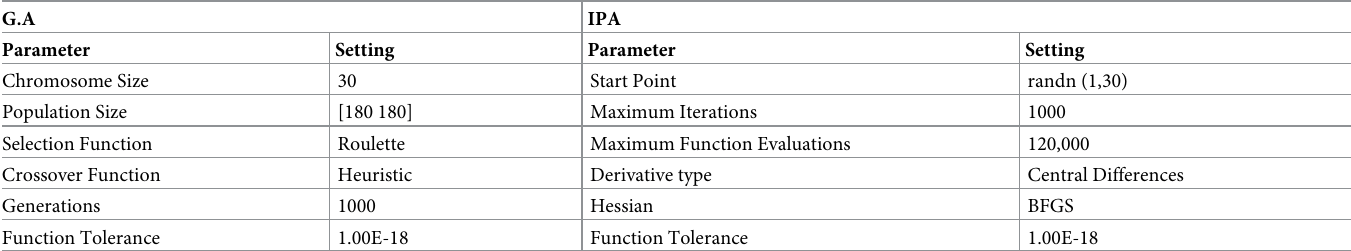
Table 9. Parameter settings.